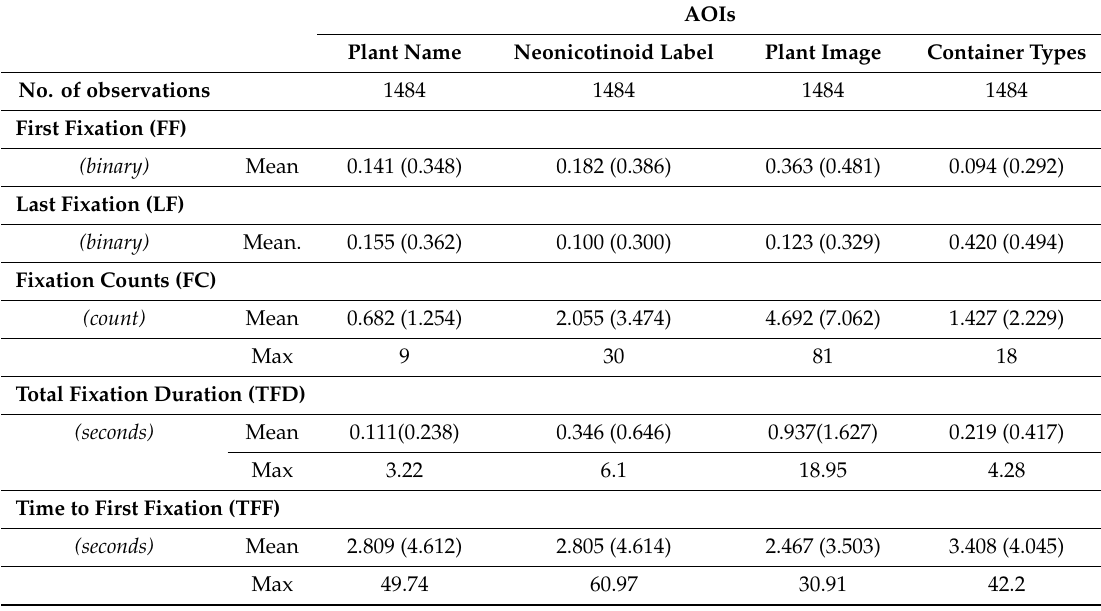
Table 3. Visual attention to plant name, neonicotinoid label, plant image, and container types.